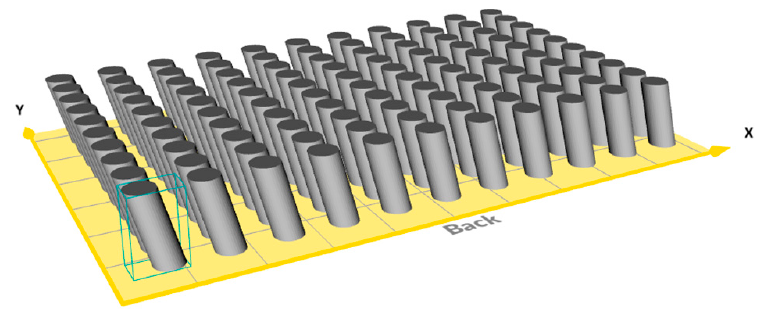
Figure 5. Components (110 in number) of CG3 arranged on the building platform.